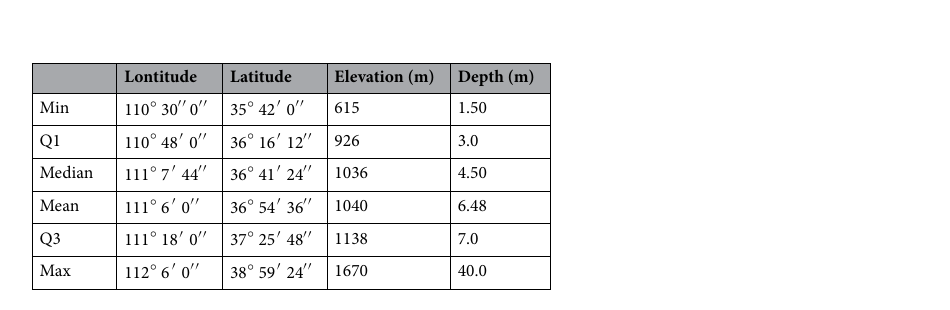
Table 5. Location information for samples in Lv Liang summarised. Min minimum, Q1 1st quantile, Q3 3rd quantile, Max maximum.